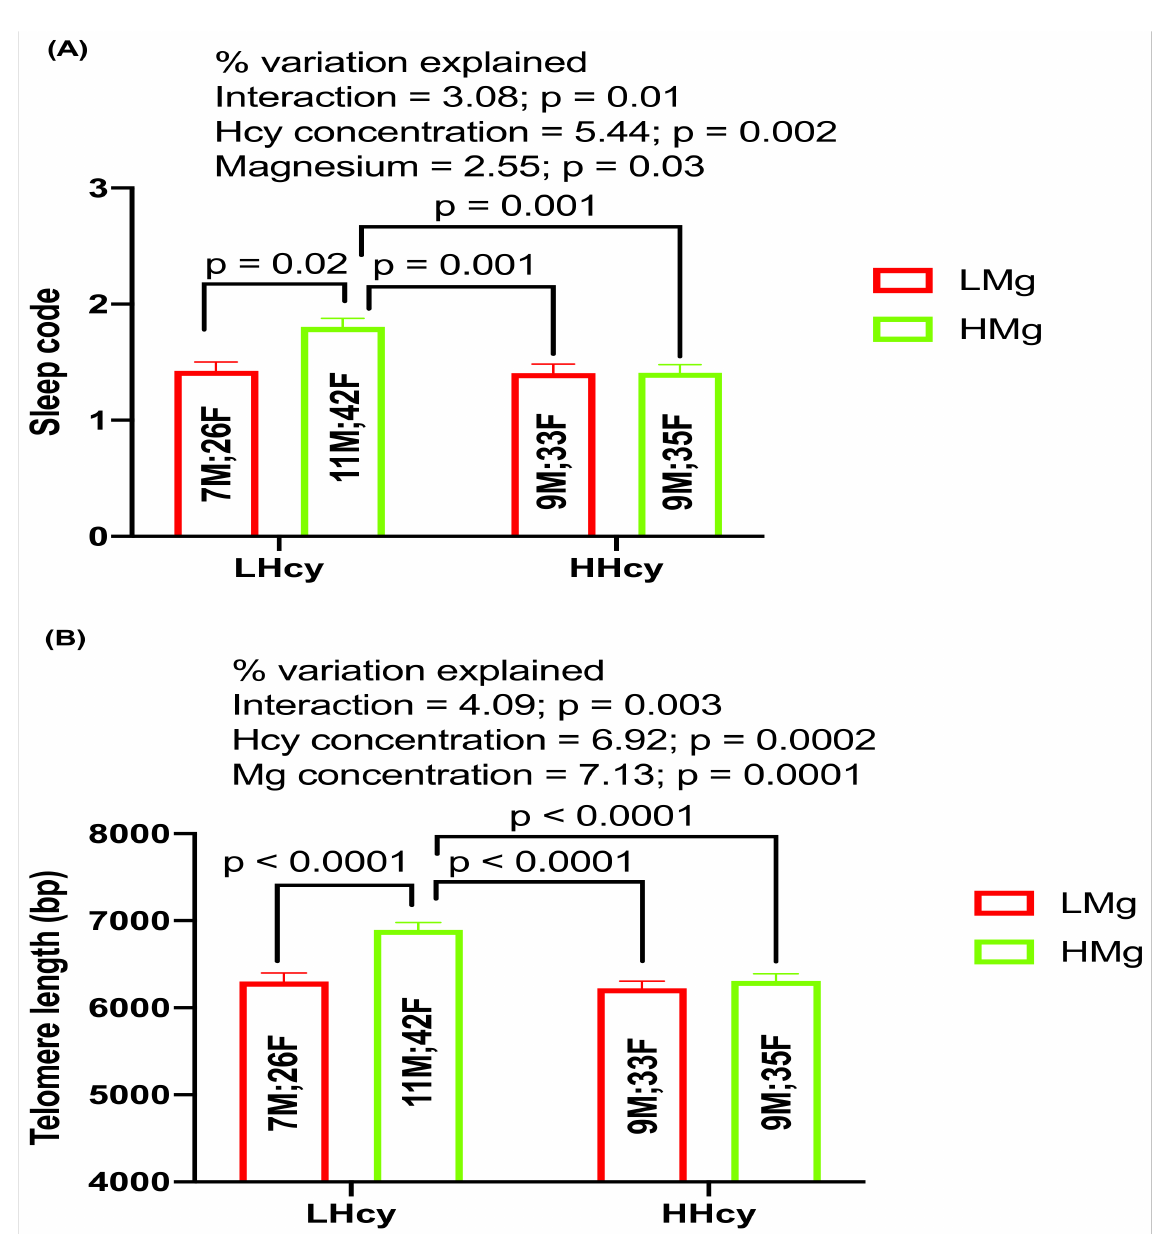
Figure 5. ( A ) Two-way ANOVA analysis of independent and interactive effects of homocysteine and magnesium on sleep duration (sleep code as 1 for <7 h and sleep code 2 as ≥ 7 h), and ( B ) two-way ANOVA analysis of independent and interactive effects of homocysteine and magnesium on telomere length. Number of subjects in each category (male and female) is shown in the middle of each